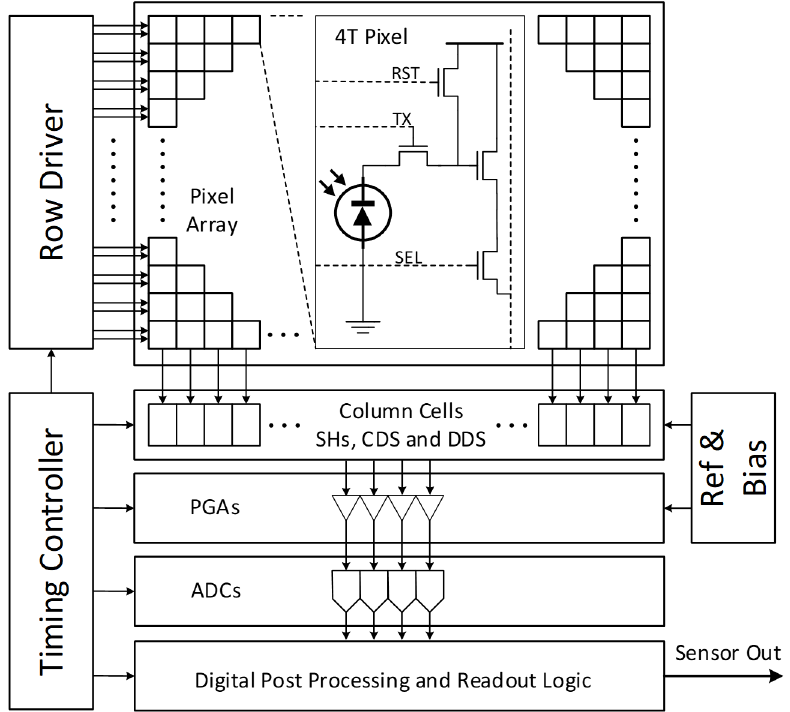
Figure 1. Typical CMOS image sensor block